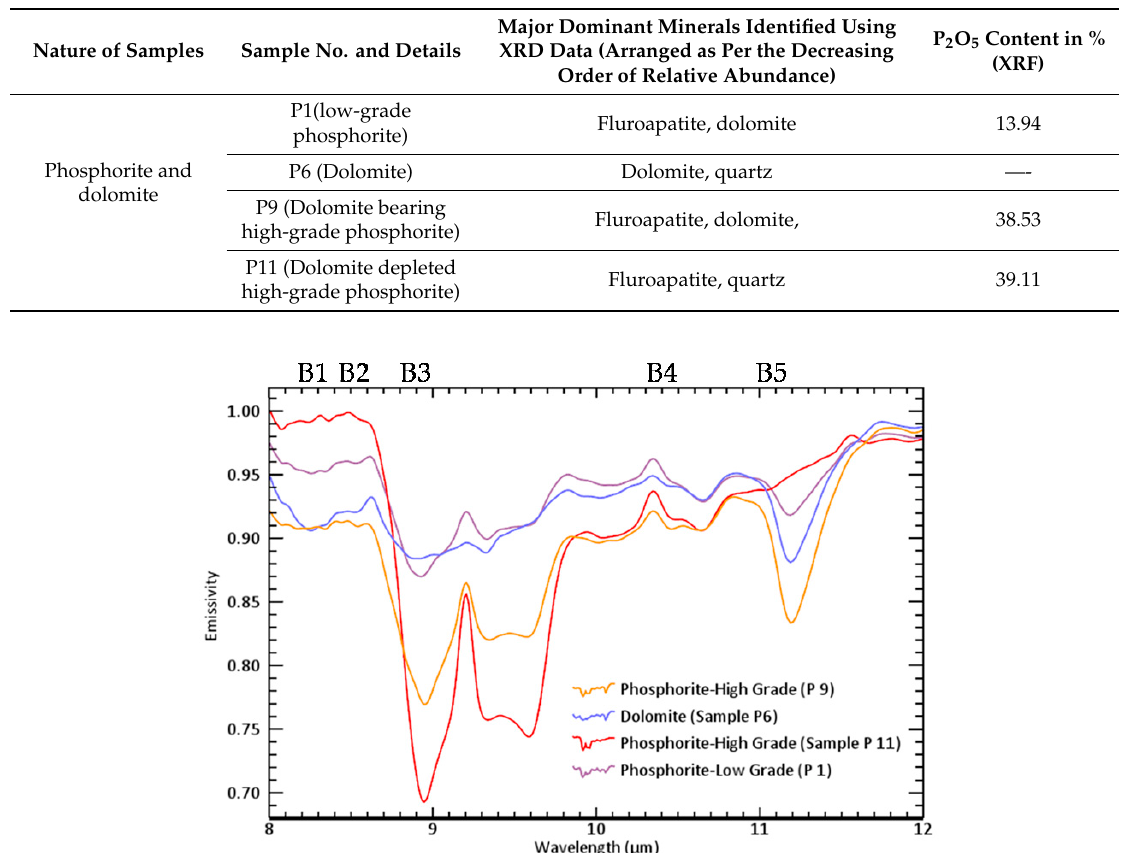
Table 2. Results of XRD and X-ray fluorescence (XRF) analysis of representative samples of phosphorite and dolomite to identify the presence of the dominant mineral phases and their relative proportion along with the P 2 O 5 Content [30].